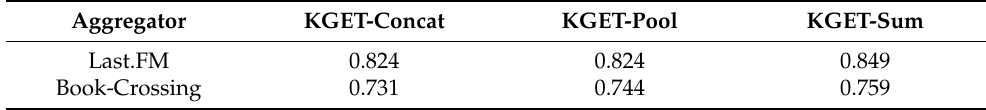
Table 8. The influence of aggregator in